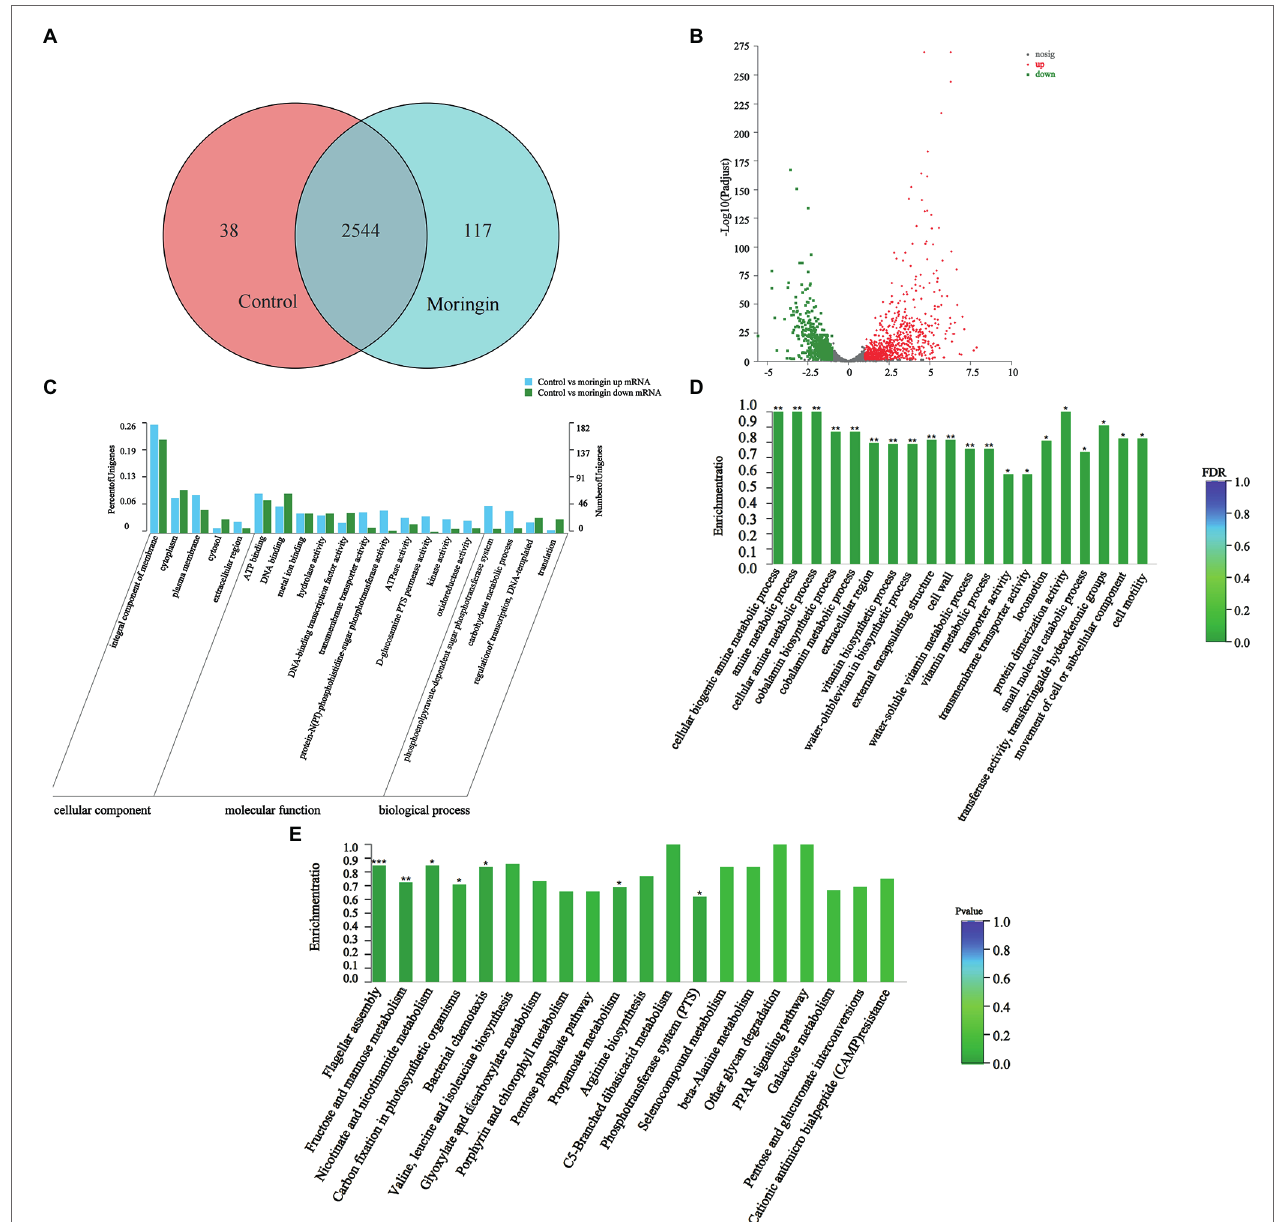
FIGURE 2 | Transcriptome analyses of Listeria monocytogenes after treatment with moringin. (A) Venn diagram. (B) Percentages of up- and downregulated genes for each group indicated on a volcano plot. (C) GO classification of DEGs. (D) GO enrichment of DEGs. (E) Statistical enrichment of differentially expressed genes in KEGG pathways. * p < 0.05, ** p < 0.01, and *** p <